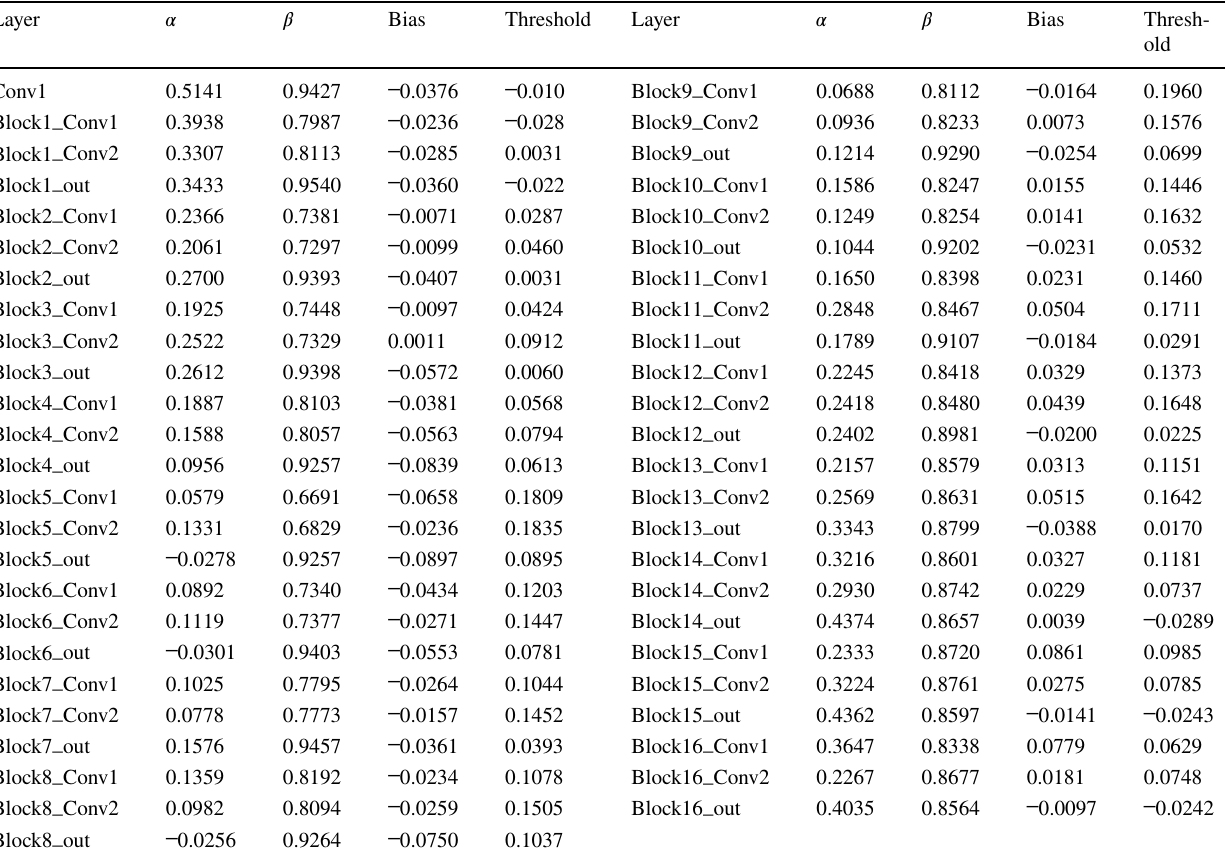
Table 7 The values of DPReLU’s four learnable parameters for each layer of ResNet50 trained on CIFAR-10, at epoch point showing the best test accuracy